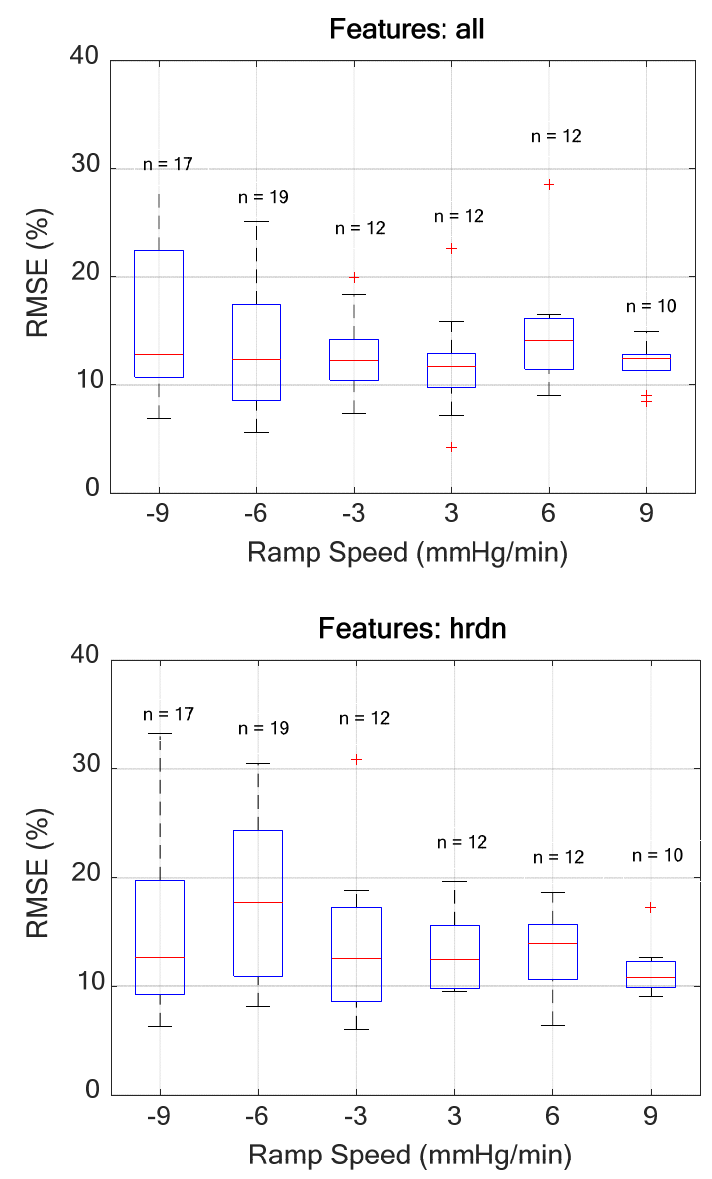
Figure 3. Box plots showing statistical characteristics of the RMSEs binned per ramp speed. The median (red line), 25th and 75th percentiles (top and bottom edges of the blue box), outliers (red crosses), and valid maximum and minimum values that were not classified as outliers (whiskers). The top plot shows the RMSEs for the all-features GB tree model binned without baseline normalization per ramp speed, while the bottom plot shows the same data for the model that only uses HRDN.